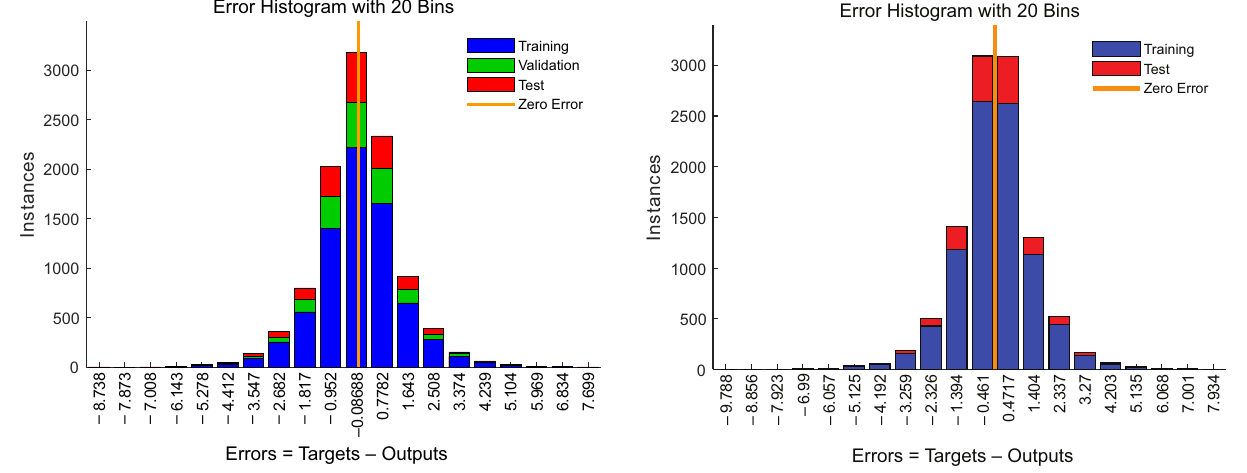
Figure 5. Training error with Levenberg–Marquardt (left) and Bayesian Regularization (right)